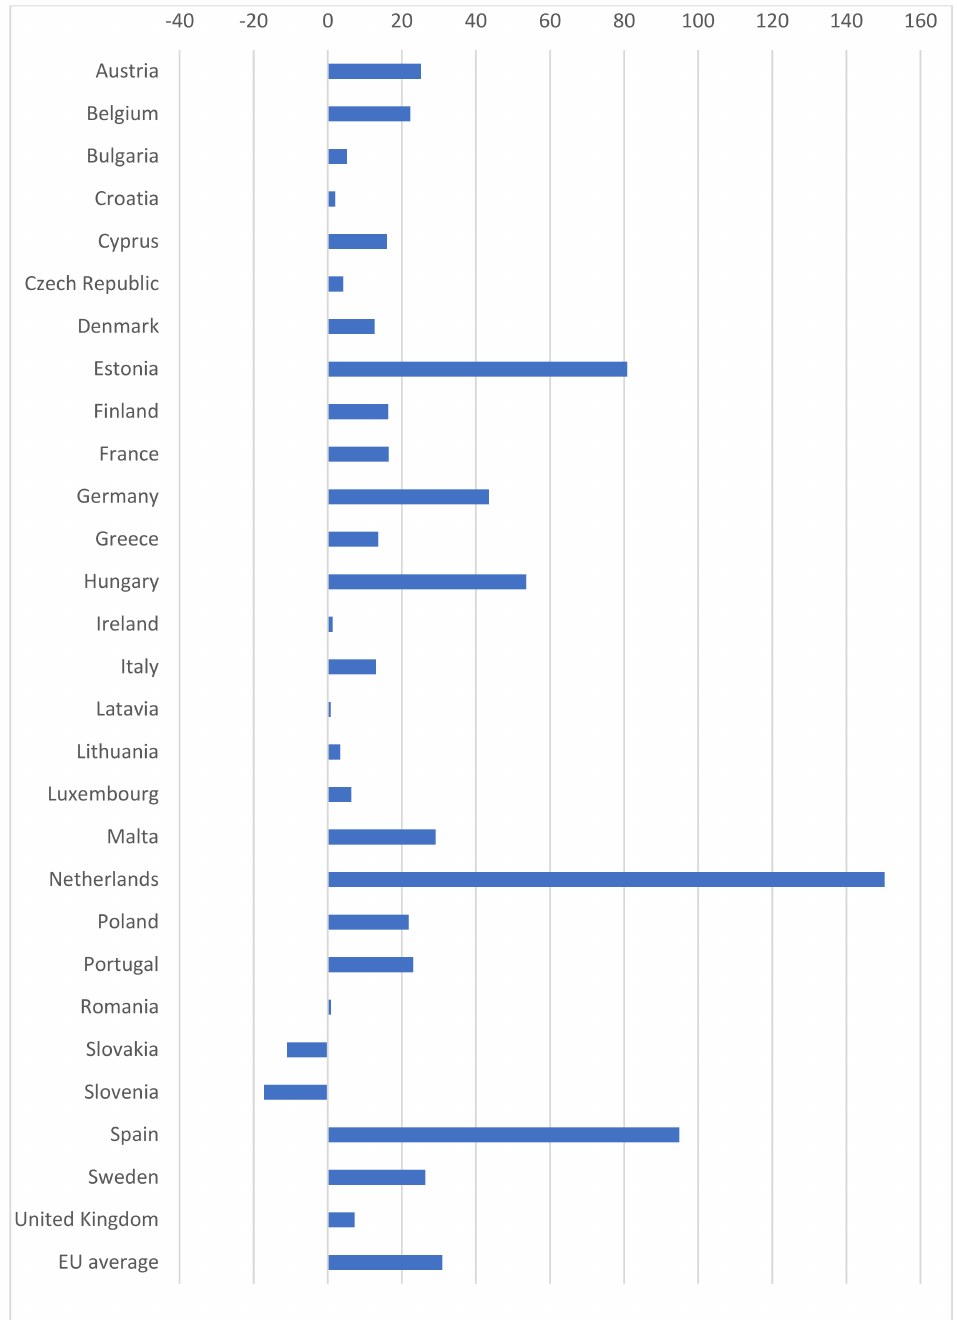
Figure 3. Photovoltaic capacity installed in European Union countries in year 2019. Source: Own analyses based on data: